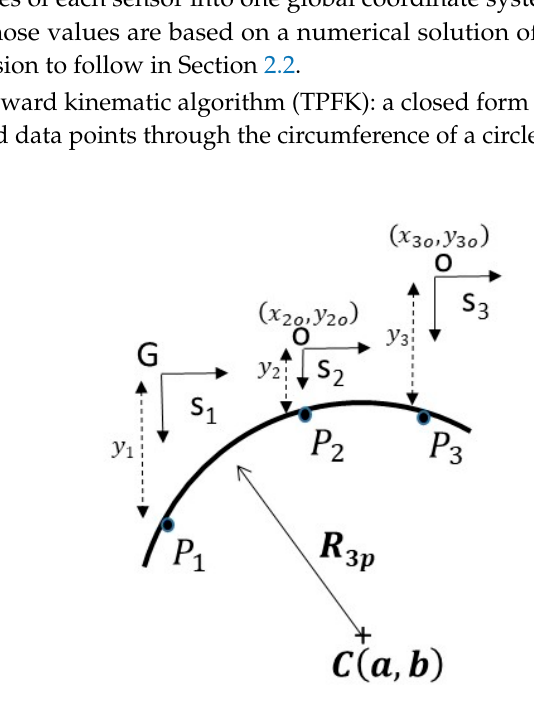
Figure 1. Three-point method: Measurement of the circle geometry by using three arbitrary points on an arc { P 1 , P 2 , P 3 } using global reference G located at s 1 . The sensors are arranged in parallel to reduce system complexity and set-up error.